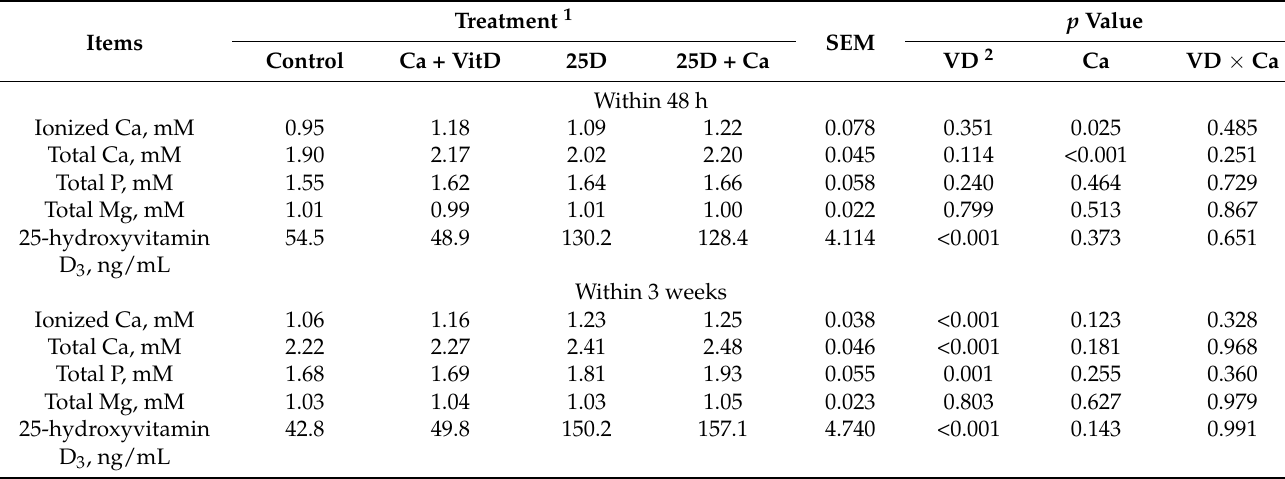
Table 3. Effect of 25-hydroxyvitamin D 3 and oral calcium bolus on serum minerals and vitamin D 3 metabolites of postpartum Holstein cows.